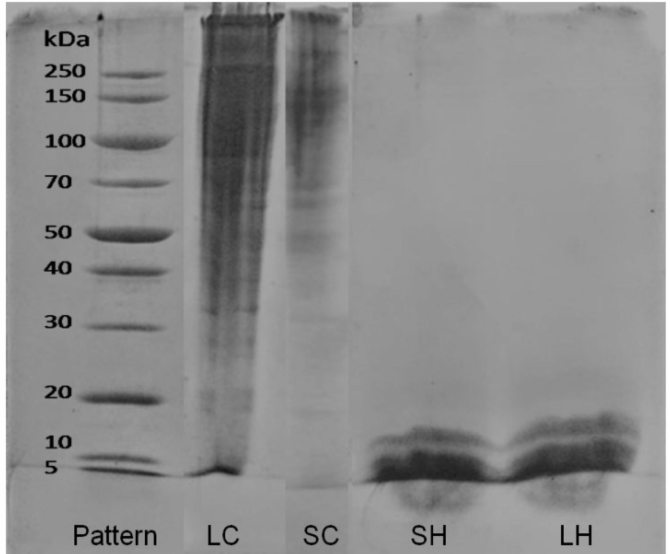
Figure 2. Electrophoresis (SDS-PAGE) of sheep (SC) and lamb (LC) collagens; and of sheep (SH) and lamb (LH)